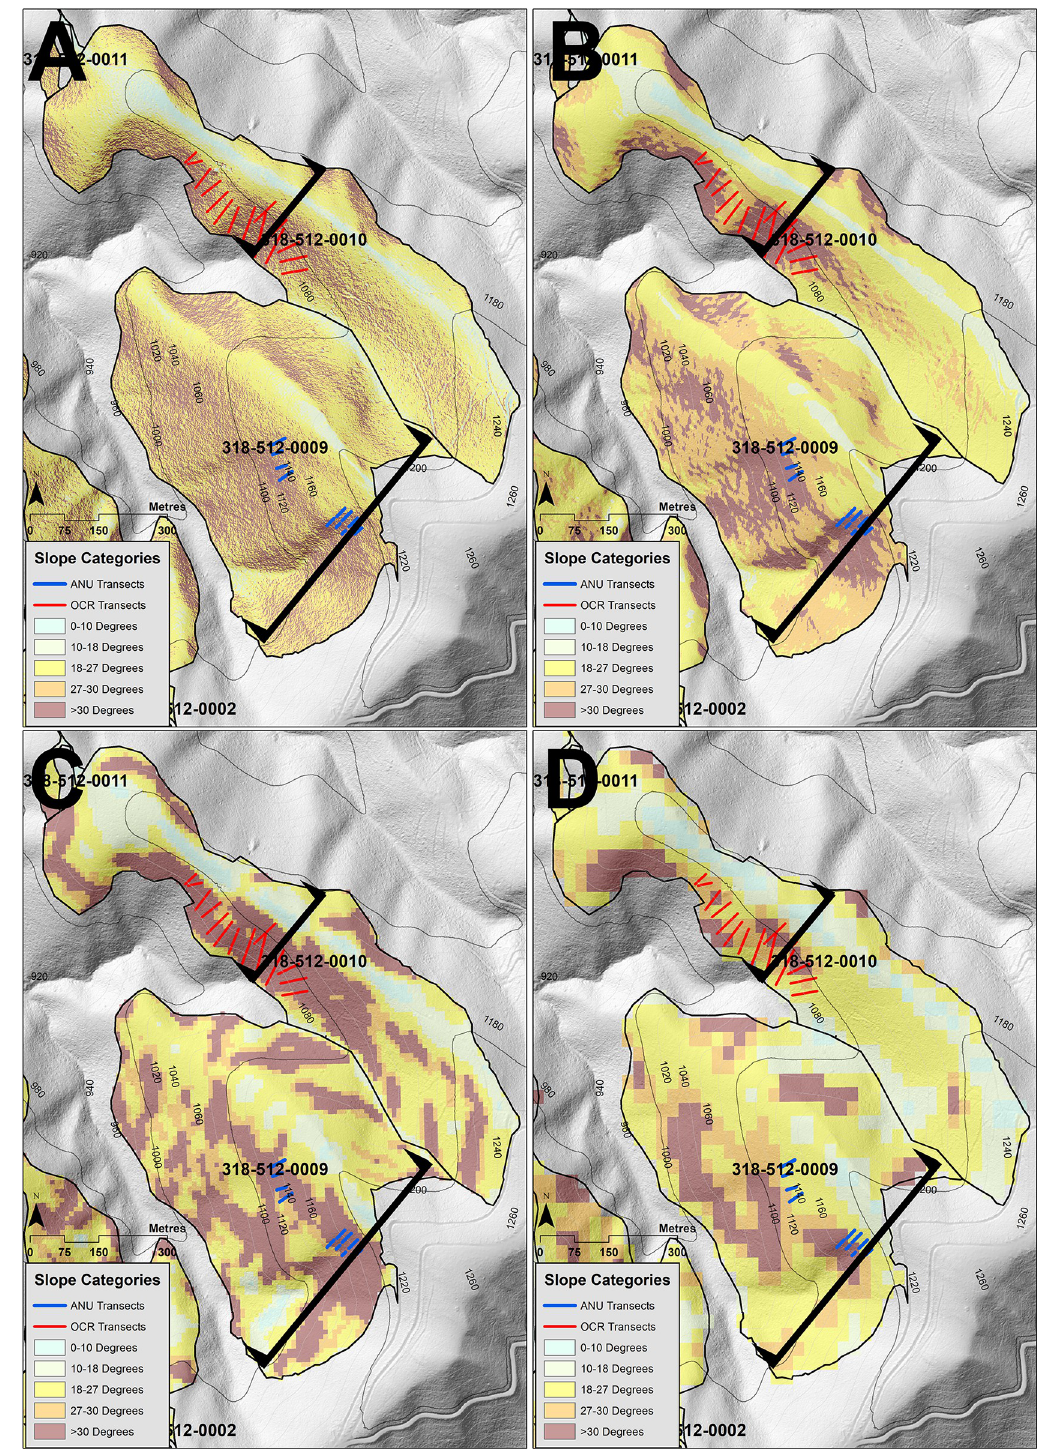
Fig 7. Comparison of slope calculations for Cutblock 318-512-0009 and 318-512-0010. LiDAR derived slope at 1m resolution (Fig 7A); LiDAR derived slope with an average slope neighbourhood radius of 5m (Fig 7B); STRM derived slope at 1 arc second resolution (Fig 7C); DTM derived slope at 10m resolution (Fig 7D). Blue and Red lines show measured transects for the ANU and OCR Transects, respectively. Slope cross sections A and B are shown.